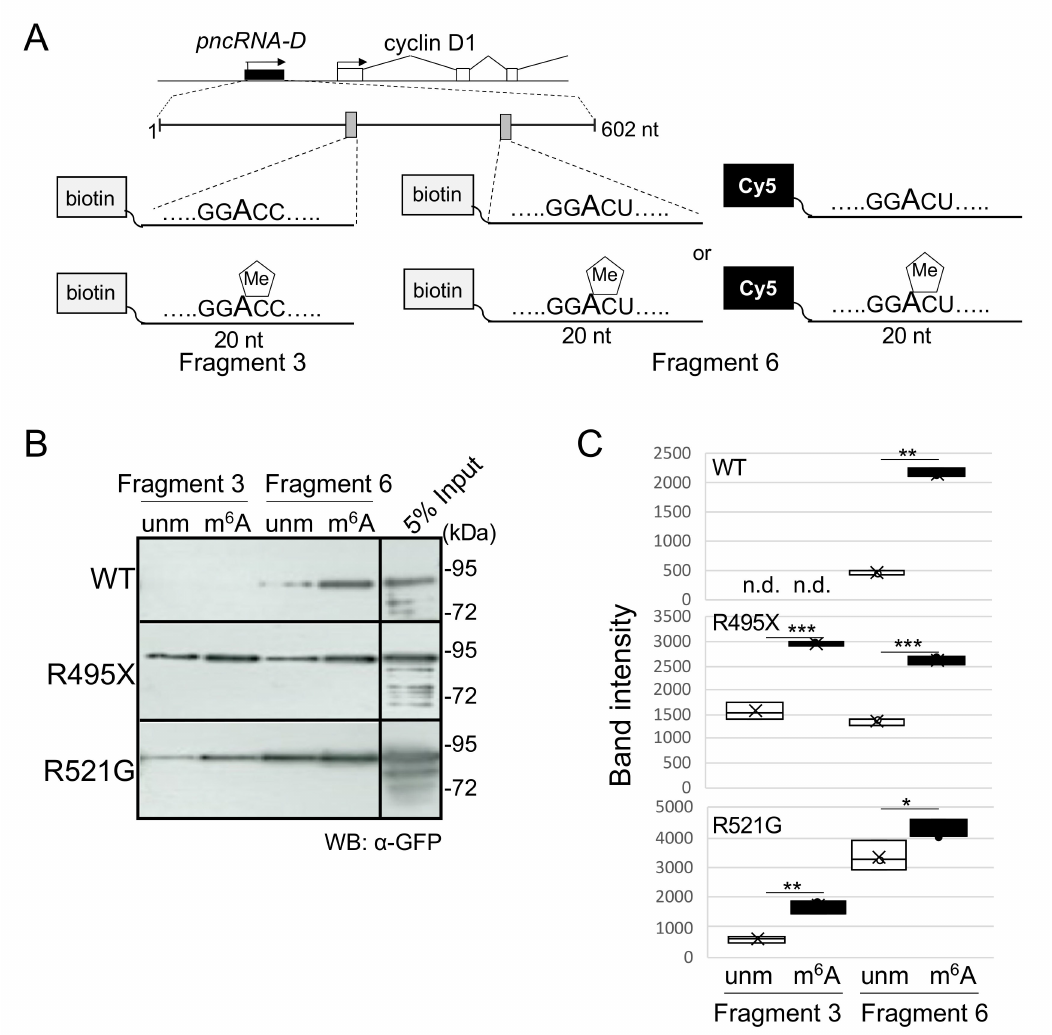
Figure 1. TLS/FUS bound preferentially to m 6 A-modified RNA fragments. ( A ) Schematic drawing of the region around the cyclin D1 promoter. Positions of RNA fragments used in this study are described. Two sequences (Fragments 3 and 6) were selected from the lncRNA pncRNA-D (black box). Biotinylated RNA sequences were prepared with or without m 6 A modification, and for Fragment 6, we also prepared sequences labeled with Cy5. ( B , C ) RNA pull down assay followed by Western blot analysis. Biotinylated RNA fragments were incubated with purified strep-GFP-TLS/FUS (WT or mutated) proteins, and the band intensities were quantified as in ( C ). n.d., not detected; unm, unmodified fragments; m 6 A, m 6 A modified fragments. n = 3. * p < 0.05, ** p < 0.01, *** p <